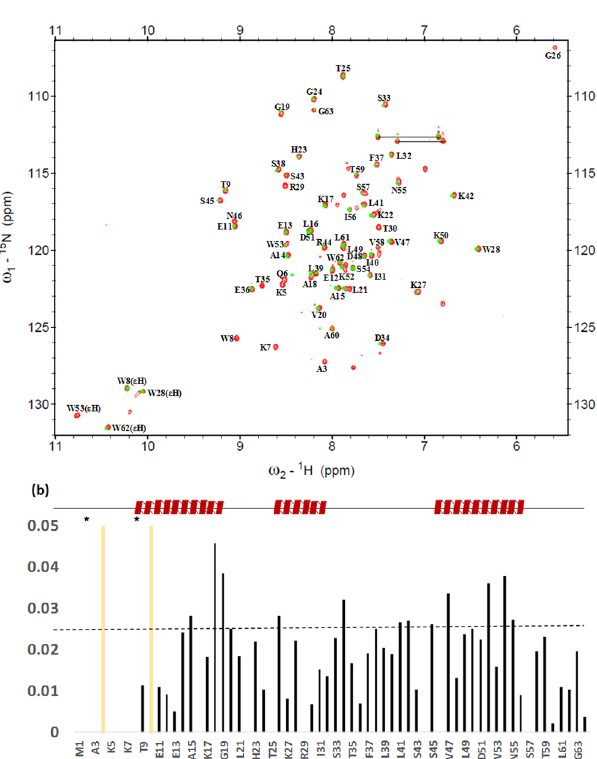
Figure 8. ( a ) 1 H- 15 N HSQC spectra of AtTRB2 with or without treatment with GO (2 µ g/ml). Native peaks of AtTRB2 in red color and GO-AtTRB2 in green color. Each peak corresponds to an amide N and H of each amino acid residue. ( b ) Amide chemical shift perturbation of AtTRB2 upon binding with